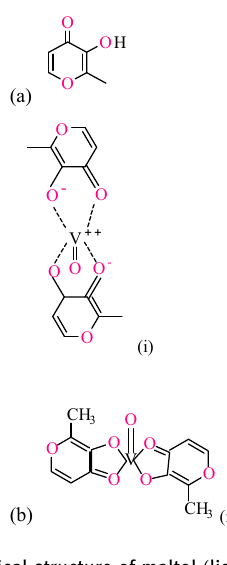
Figure 9: ( a ) Chemical structure of maltol ( ligand ) . ( b ) Chemical structure of bis ( maltolato ) oxovanadium ( IV ) ( BMOV ) in ionic ( i ) and neutral ( ii )